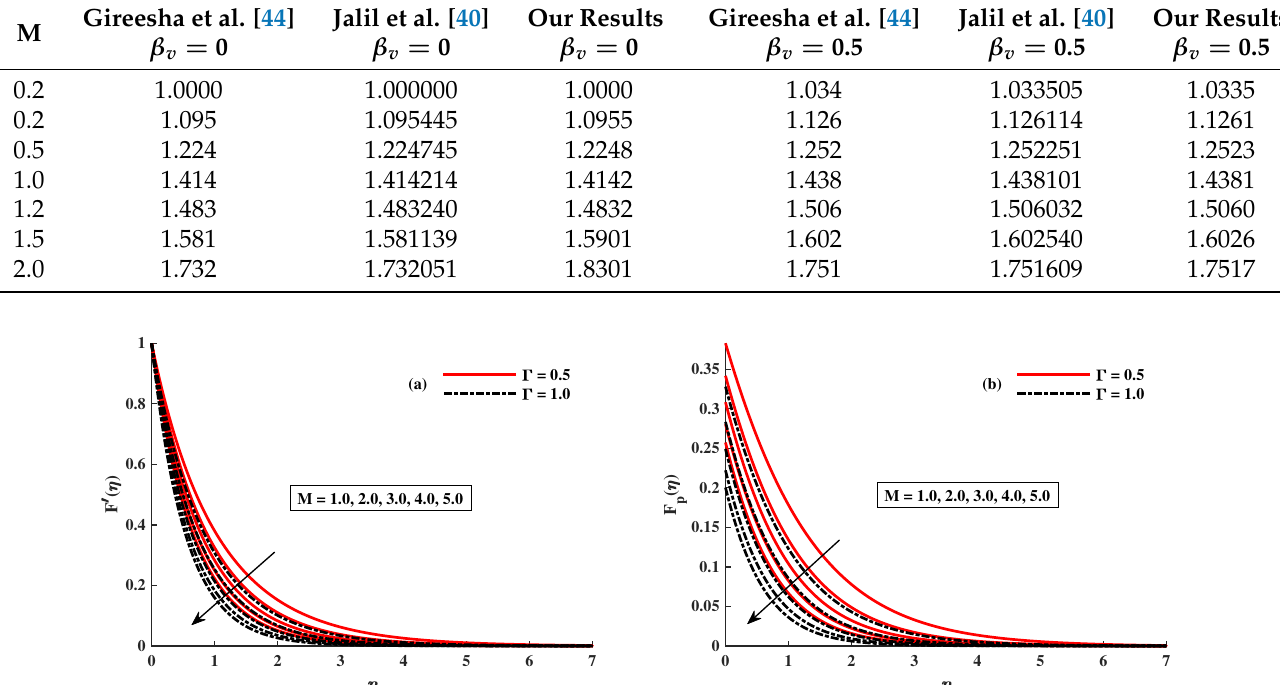
Table 1. The skin friction coefficient was compared for different inputs of β t and M while all other parameters were ignored.